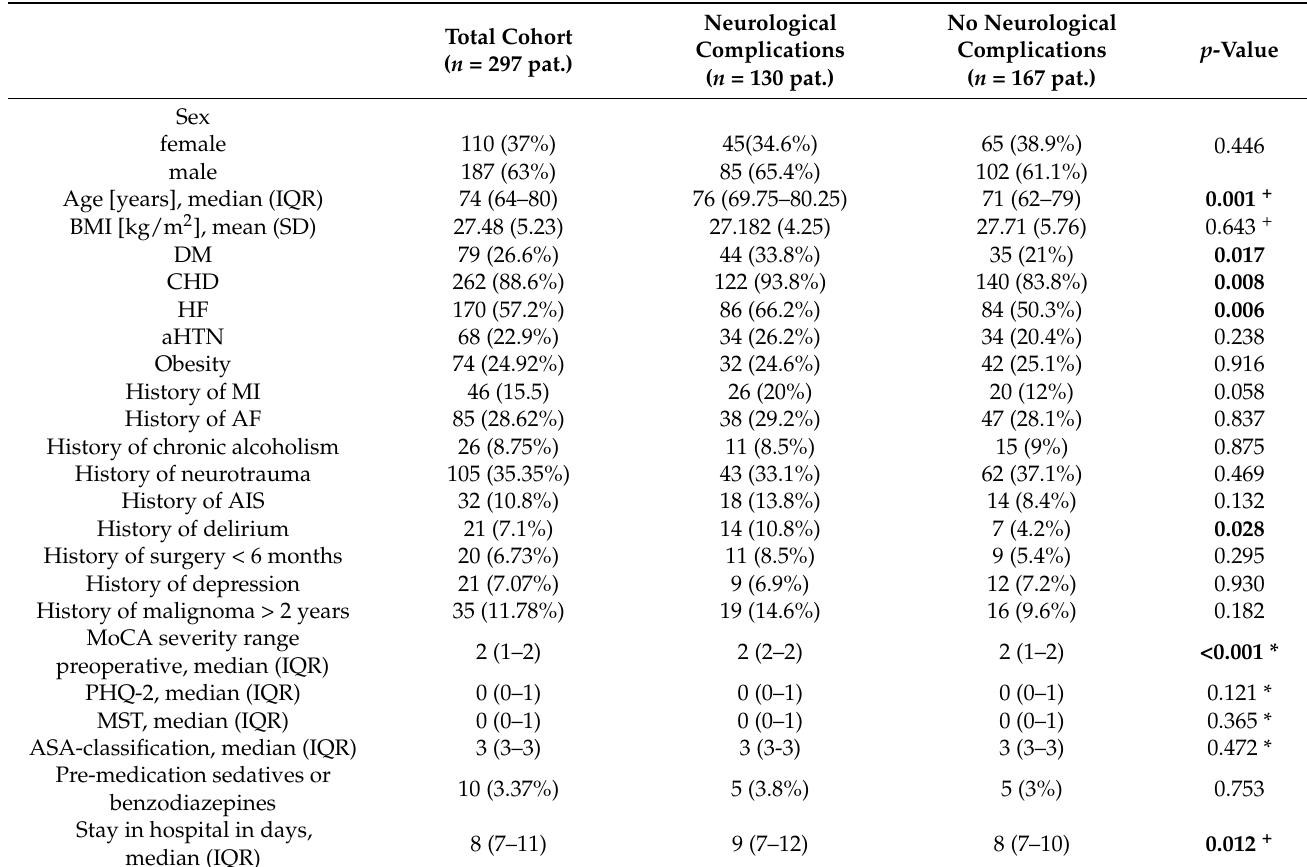
Table 1. Clinical characteristics of patients with cardiac surgery or percutaneous valve replacement with or without neurological complications. Total Cohort ( n = 297